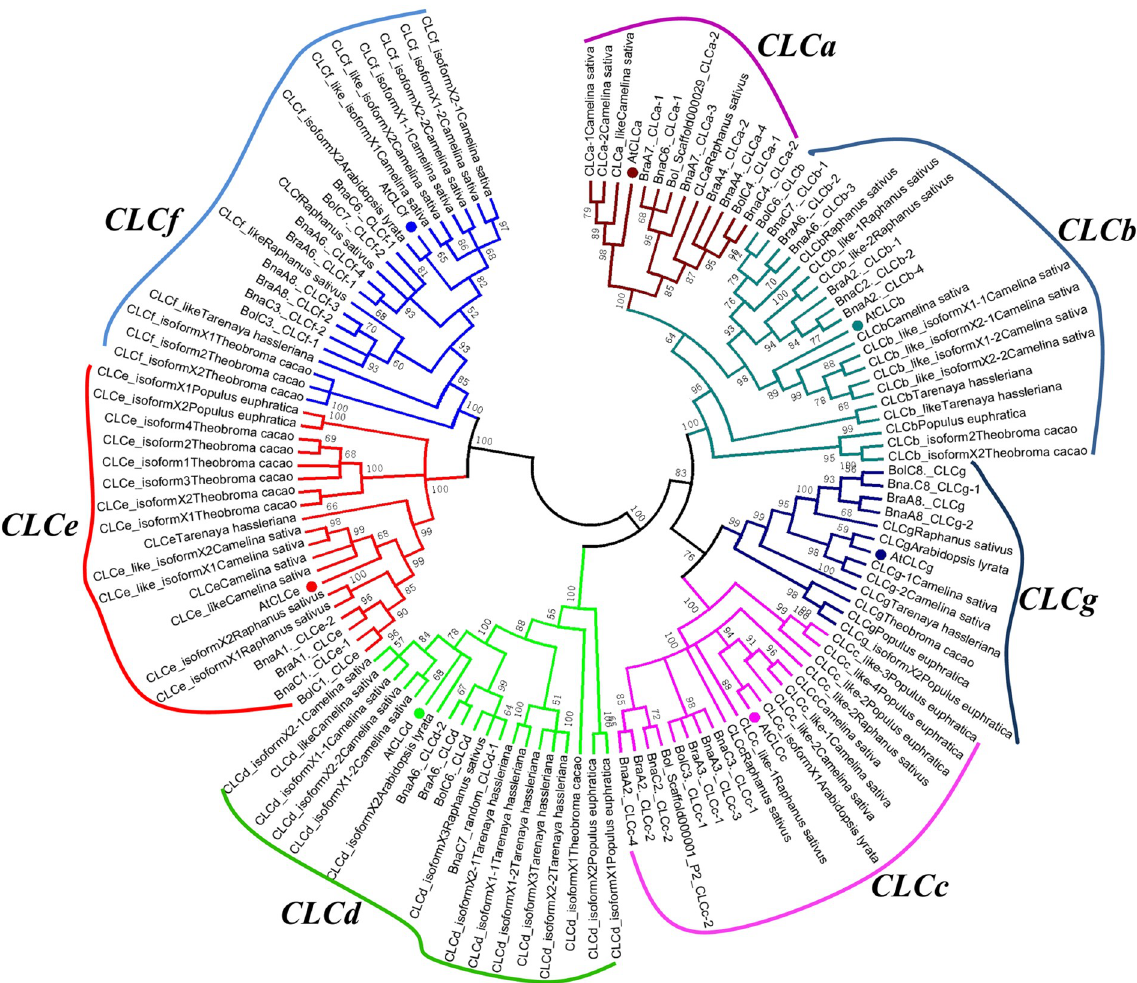
Fig 2. Phylogenetic tree of CLCs in diverse plant species. A total of 118 protein sequences from 10 species including Brassica napus , Brassica rapa , Brassica oleracea , Arabidopsis thaliana , Arabidopsis lyrata , Camelina sativa , Populus euphratica , Raphanus sativus , Tarenaya hassleriana and Theobroma cacao were multi-aligned using the ClustalW program, and then an unrooted phylogenetic tree was constructed using the software MEGA6.06 with the neighbor-joining method. The percentage of replicate trees, in which the associated taxa clustered together in the bootstrap test (1000 replicates), are shown next to the branches.